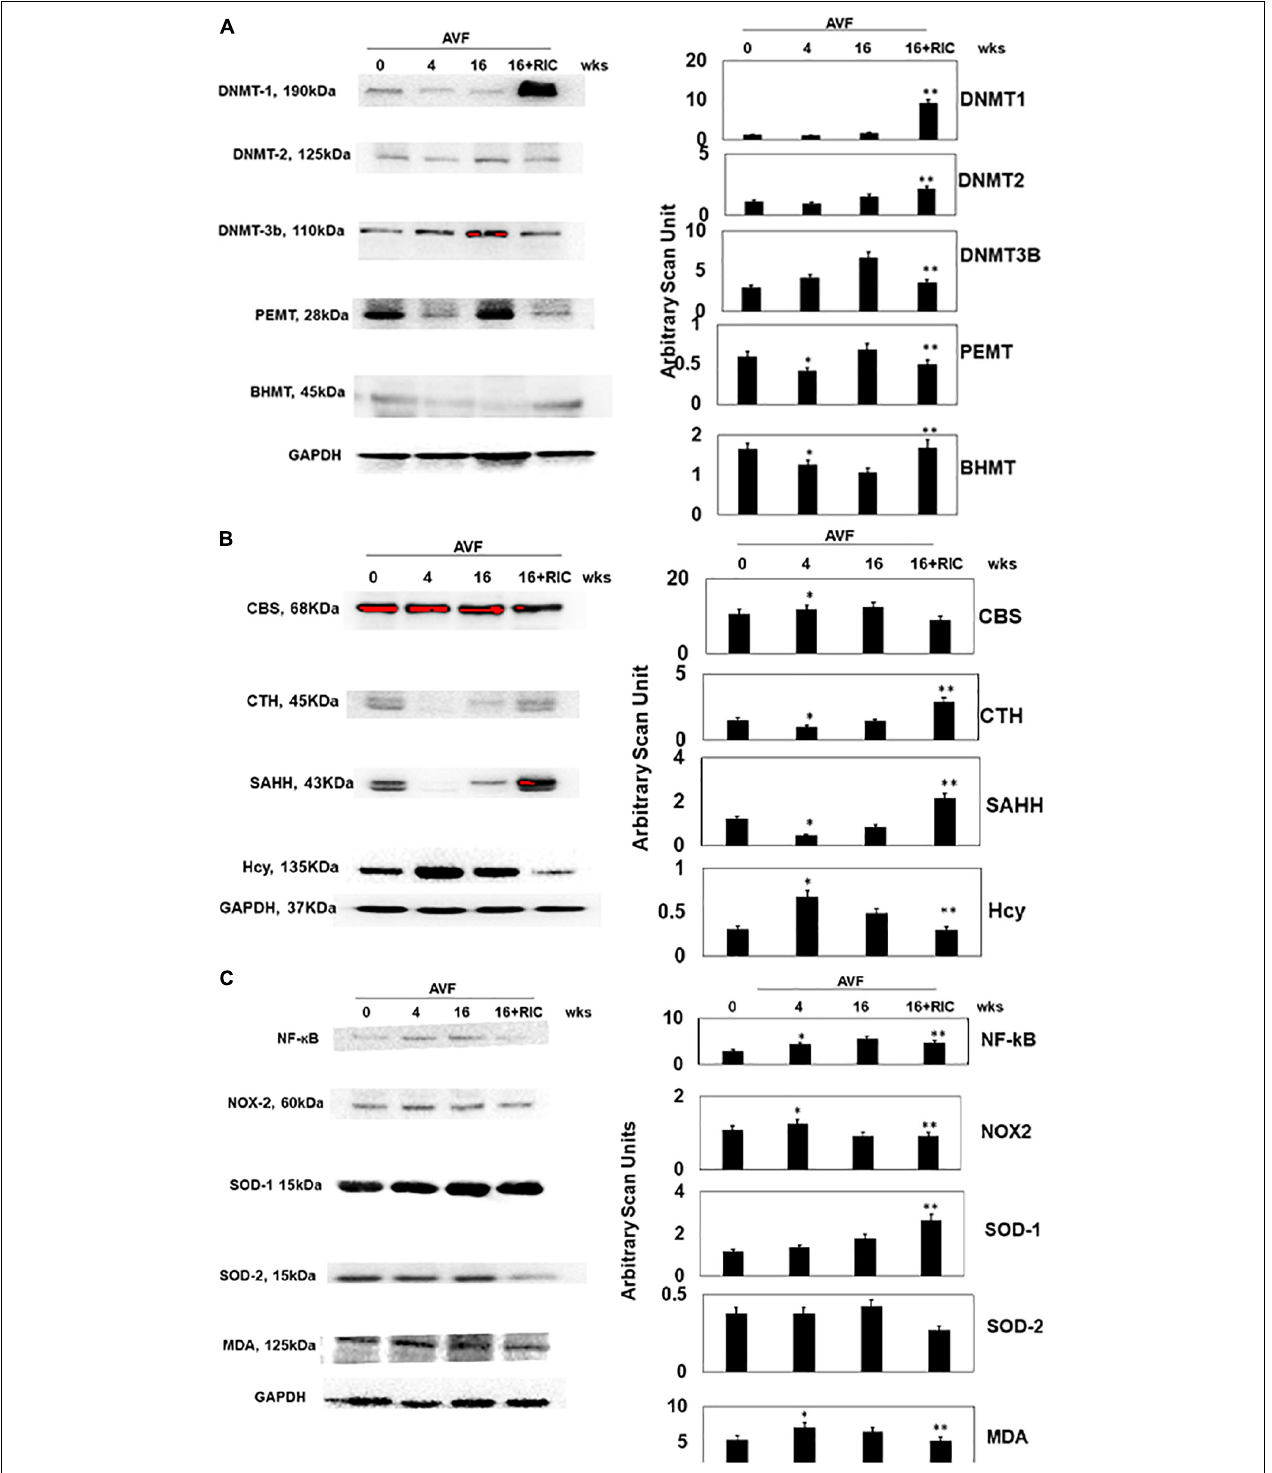
FIGURE 5 | (A) The Western blot analysis of epigenetic cardiac levels of DNA methyl transferase 1 (DNMT1), DNMT2, DNMT3b, phosphatidylethanolamine methyltransferase (PEMT), and BHMT. Bar graph of relative scan unit representation with ± SD from n = 5–8. (B) The Western blot analysis of homocysteine metabolism cardiac levels of CBS, CTH, S-adenosine homocysteine hydrolase (SAHH), and homocysteine (Hcy). Bar graph of relative scan unit representation with ± SD from n = 5–8. (C) The Western blot analysis of inflammatory and oxidative stress pathway cardiac levels of NF-kB, NOX2, SOD1, SOD2, and malonaldehyde (MDA). Bar graph of relative scan unit representation with ± SD from n = 5–8. * and ** indicate significant difference ( p < 0.05) either to “sham without RIC” or to “0” week.